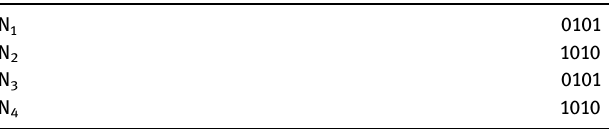
Table 1: Gene expression table of computer network nodes